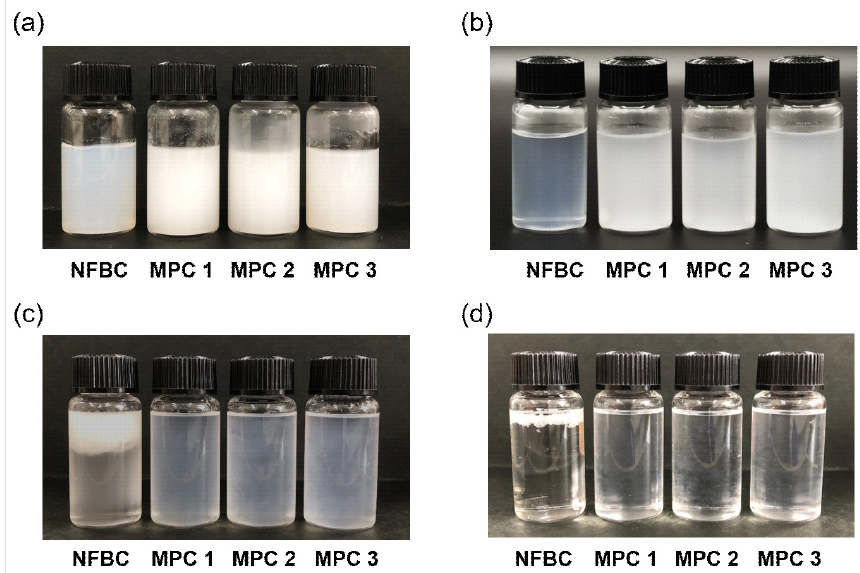
Figure 7. Dispersion states of MPC 1–3 and NFBC: ( a ) 1.0% w/v in water, ( b ) 0.1% w/v in water, ( c ) 1.0% w/v in chloroform, and ( d ) 0.1% w/v in